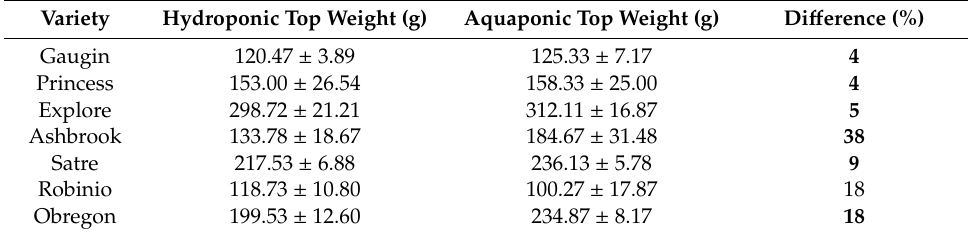
Table 4. Hydroponic vs. aquaponic NFT lettuce production results—spring 2010. The results include the mean leaf fresh weight (top weight) gain ± standard error for each system, and the percentage di ff erence between the two systems for each variety. The di ff erences in the bold font indicate that the aquaponics system mean was larger than the hydroponic system mean.